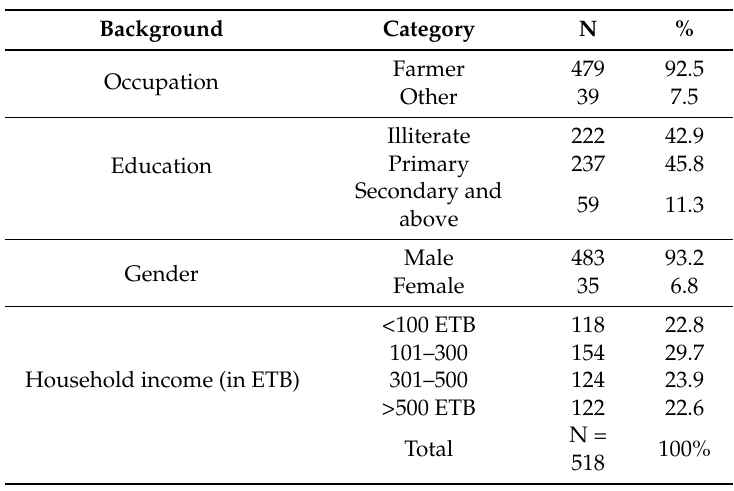
Table 1. Socio-economic background of respondents (N = 518).